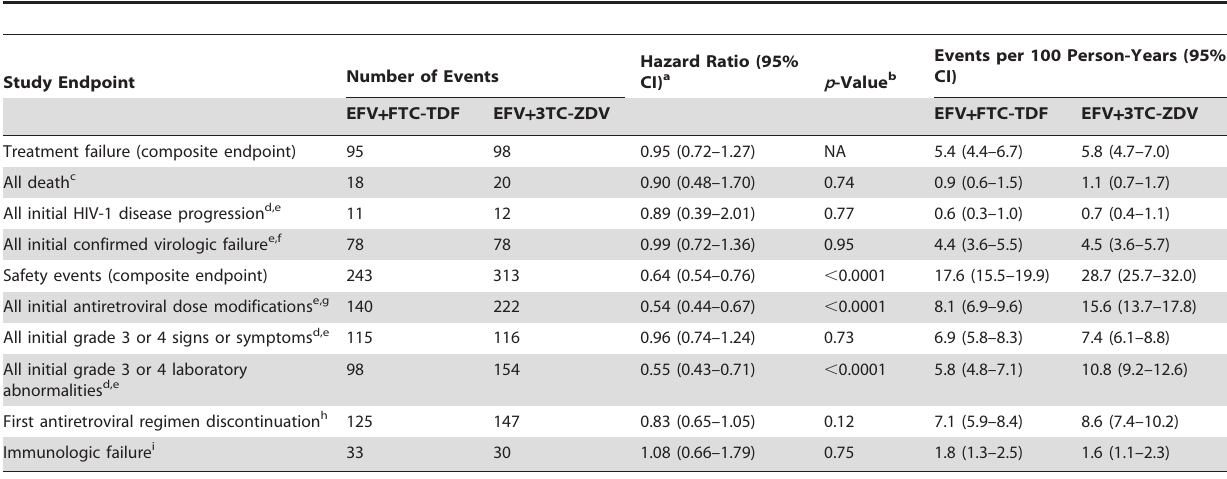
Table 2. Primary and secondary time-to-event outcomes for comparison of efavirenz plus emtricitabine-tenofovir-DF to efavirenz plus lamivudine-zidovudine using data collected through